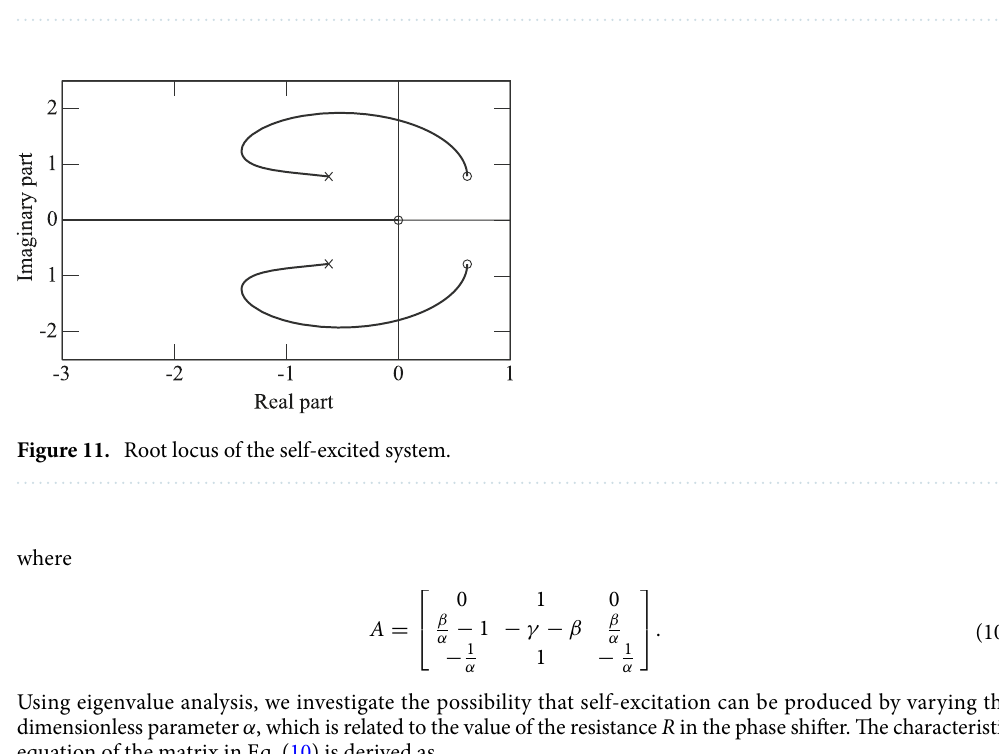
Table 2. Parameters of the microcantilever and the self-excited system.